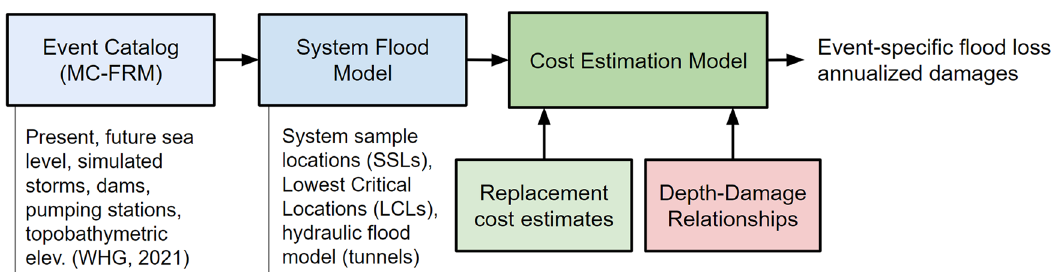
Fig. 6 Schematic representation of fl ood damage cost estimation model. A catalog of coastal fl ood events (light blue) from the Massachusetts Coastal Flood Risk Model 54 informs the system fl ood model (blue). This model, along with replacement cost estimates (light green) and depth-damage relationships (light red) inform the fl ood damage cost estimation model (green), which enables estimation of event-speci fi c fl ood losses and annualized Supplementary Fig. 2, we estimate EAL through 2100 on a t = 10-year interval. For each year of interest, we generate n = 10,000 EAL values by fi rst generating a SLR sample, then developing and sampling the associated EAL probability distribution.